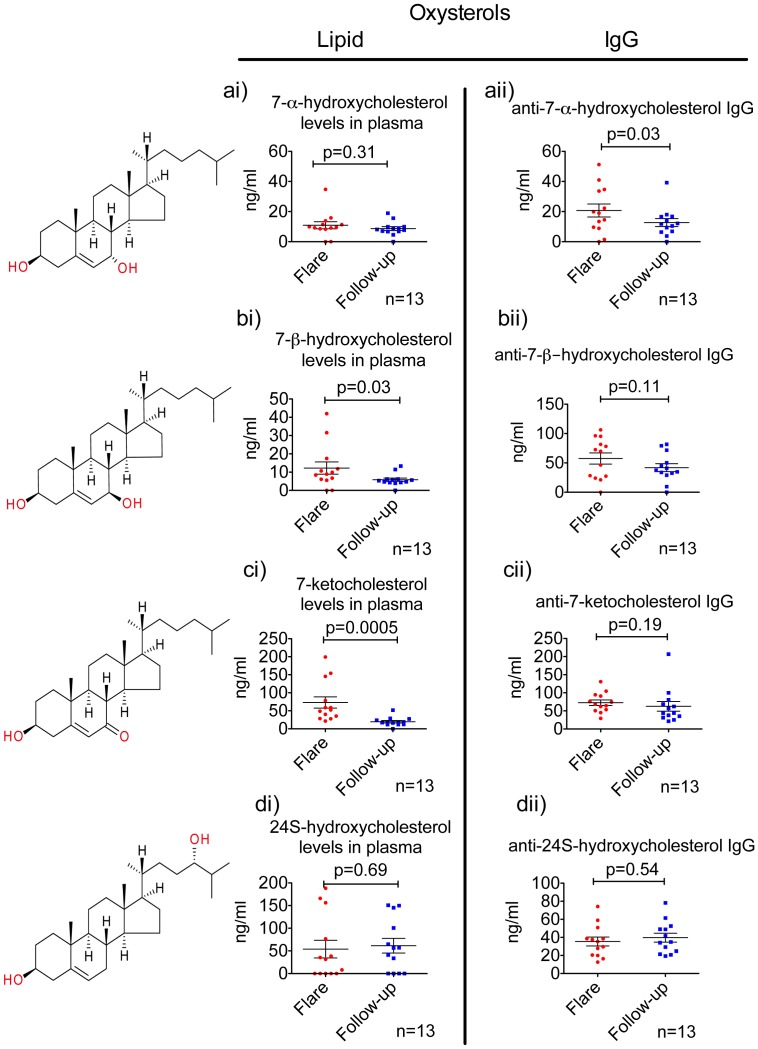
Levels of oxysterol and anti-oxysterol IgG in SLE patients’ plasma.Analysis by GC-MS and ELISA show higher levels of oxidized cholesterols or anti-cholesterol IgGs in patients during flare versus follow-up period. Figure 2ai and 2 aii. 7-α-hydroxycholesterol levels and anti-7-α-hydroxycholesterol IgG levels in plasma. Figure 2bi and 2bii. 7-β-hydroxycholesterol levels and anti-7-β-hydroxycholesterol IgG levels in plasma. Figure 2ci and 2cii. 7-ketocholesterol levels and anti-7-ketocholesterol IgG levels in plasma. Figure 2di and 2dii. 24S-hydroxycholesterol levels and anti-24S-hydroxycholesterol IgG levels in plasma. p<0.05 value was considered as significant in Wilcoxon test.